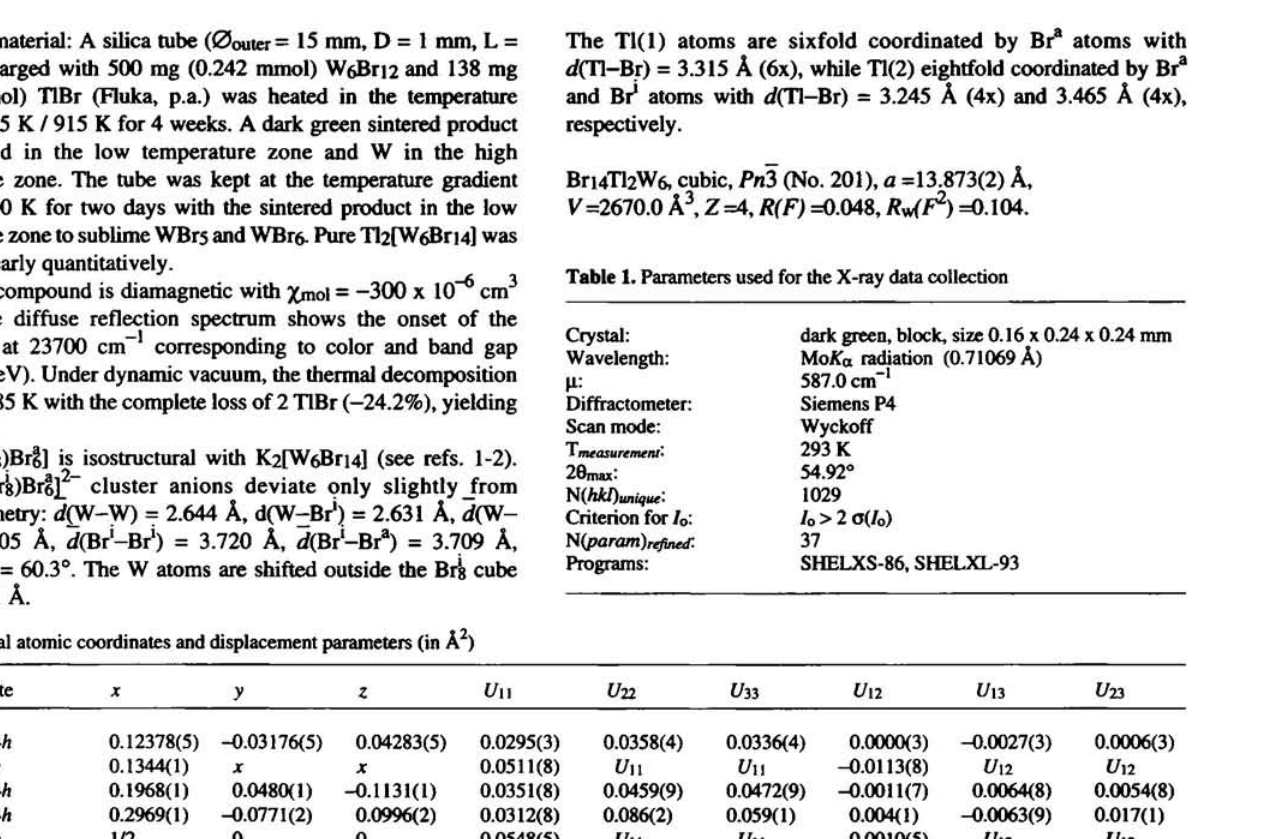
Table 2. Final atomic coordinates and displacement parameters (in Â^)